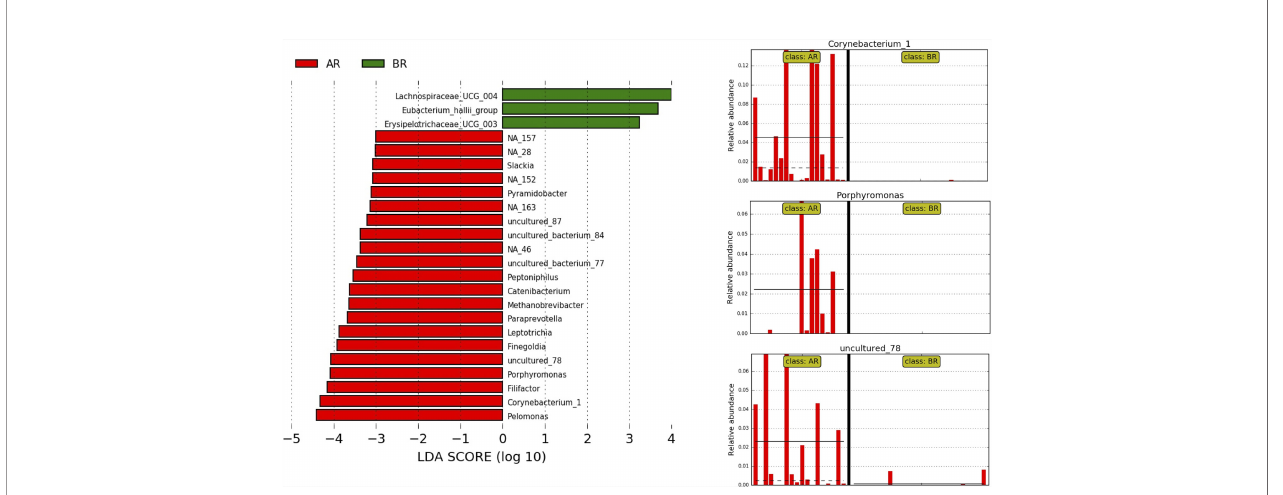
FIGURE 5 | LEfSe at the genus level for pre-treatment LARC biopsies according to the country of origin. AR samples are indicated by red and BR samples by green; horizontal bars represent the effect size for each genus, and the bar length represents the log10 LDA score, indicated by the dotted lines (vertical). The three plots on the right highlight the genera present almost exclusively in AR samples.